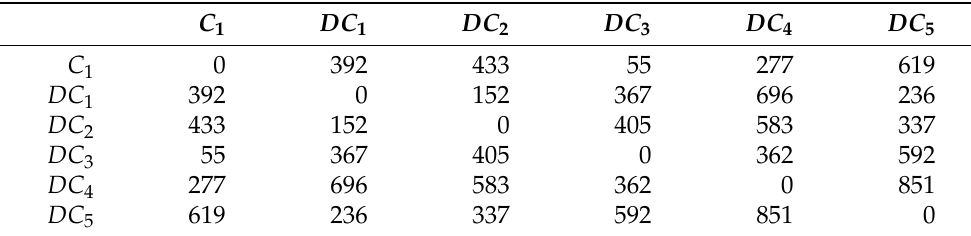
Table 5. Spatial distance between nodes [kilometer], referring to the first supplier.